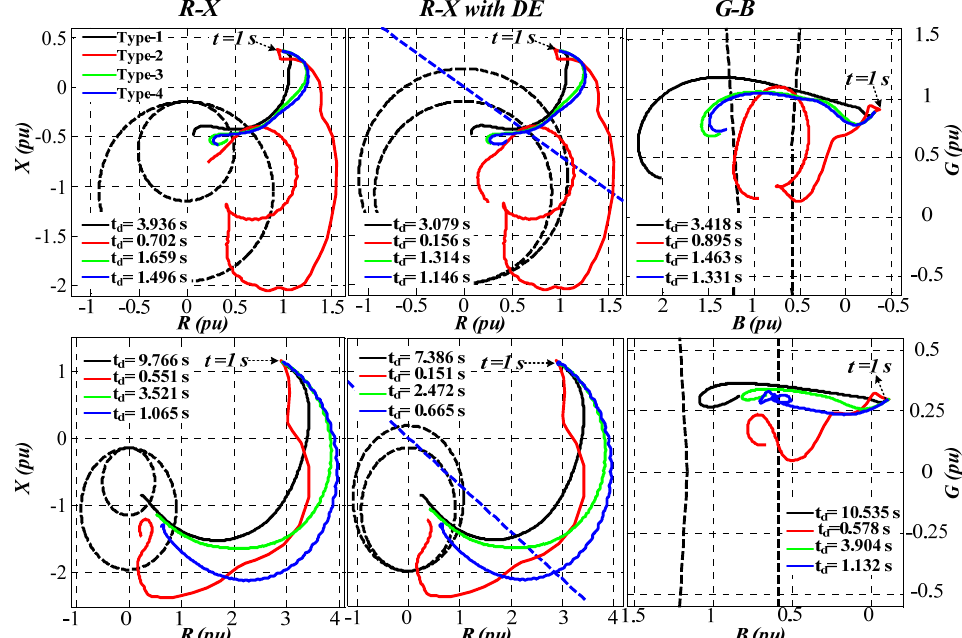
Figure 7. The performances of the traditional schemes during different CLOE events in the generator heavy loading (first row) and light loading (second row) operations; including 𝑅 − 𝑋 scheme (left), 𝑅 − 𝑋 scheme with a directional element (DE) (middle) and 𝐺 − 𝐵 scheme (right).